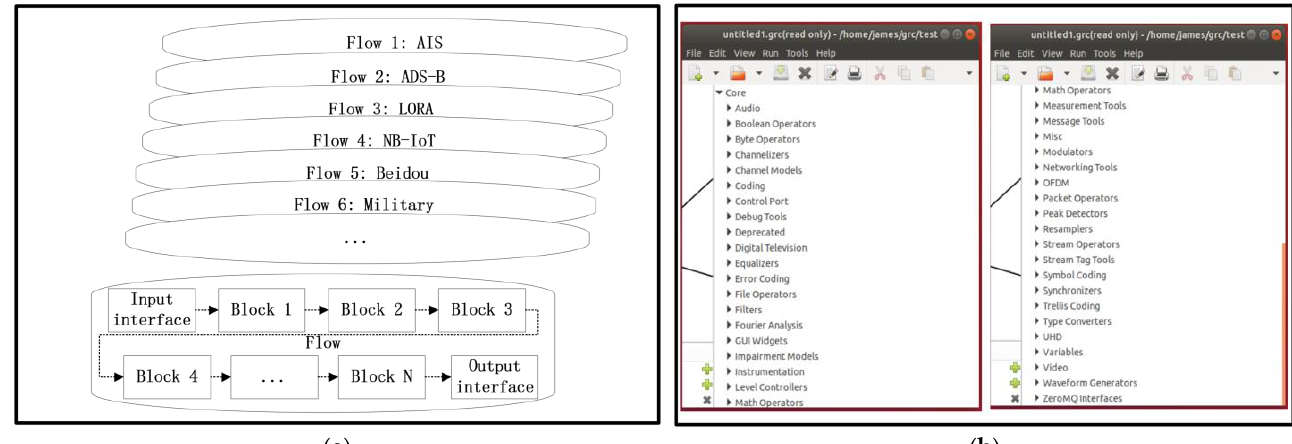
Figure 8. Gnu Radio Companion functions: ( a ) Flow and block structures; ( b ) Block design in GRC.